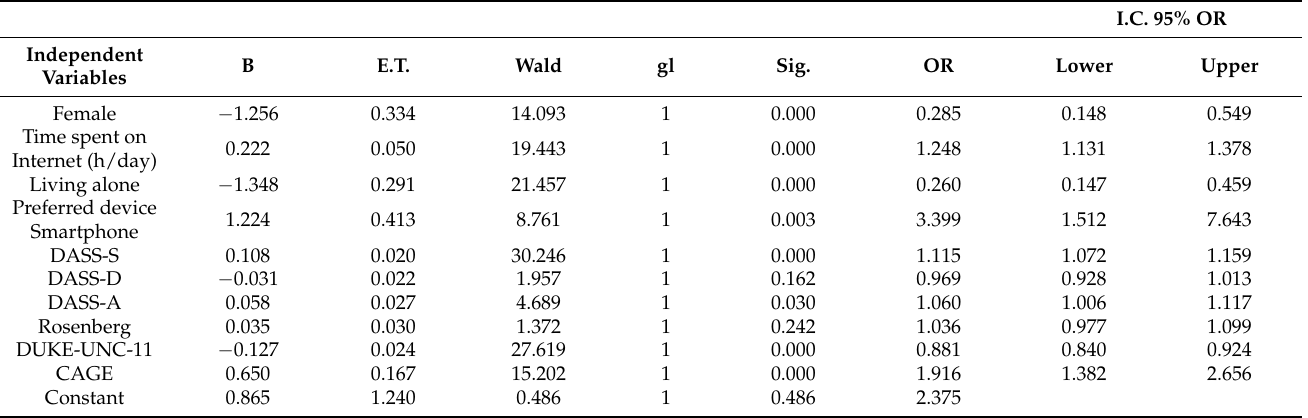
Table 4. The logistic regression analysis of the risk of having a